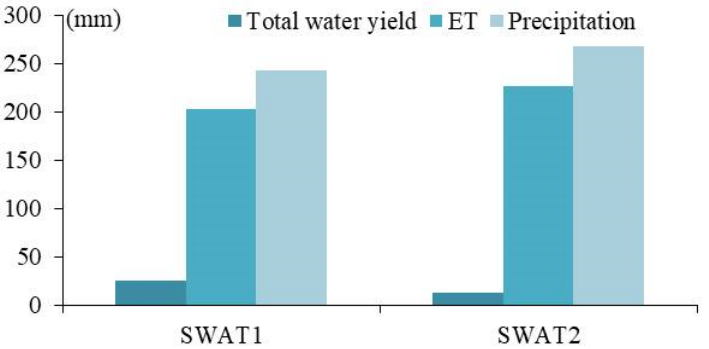
Figure 10. Water balance simulated by the Soil and Water Assessment Tool (SWAT)-1 and SWAT2 models. ET: Evapotranspiration. models. ET: